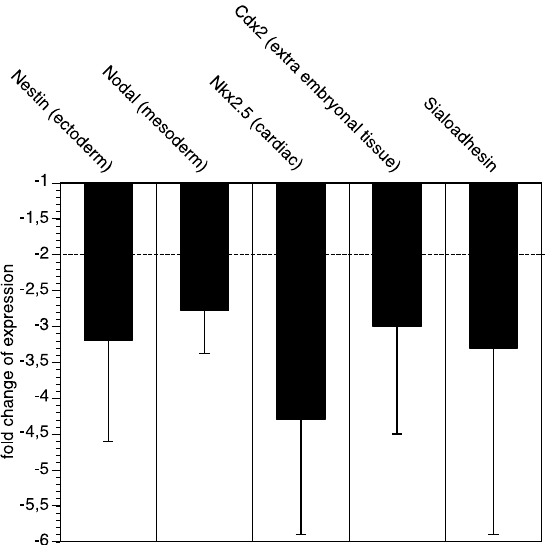
Figure 1. qRT-PCR analysis. Wild-type and GNE-deficient ( − / − ) embryonic stem cells were cultured in fetal calf serum containing medium and analyzed by qRT-PCR for expression of Nestin, Nodal, Nkx2,5, Cdx-2 and Sialoadhesin. Bars represent fold change of expression of GNE-deficient embryonic stem cells compared to wild-type embryonic stem cells. Each experiment was performed twice in triplicates.